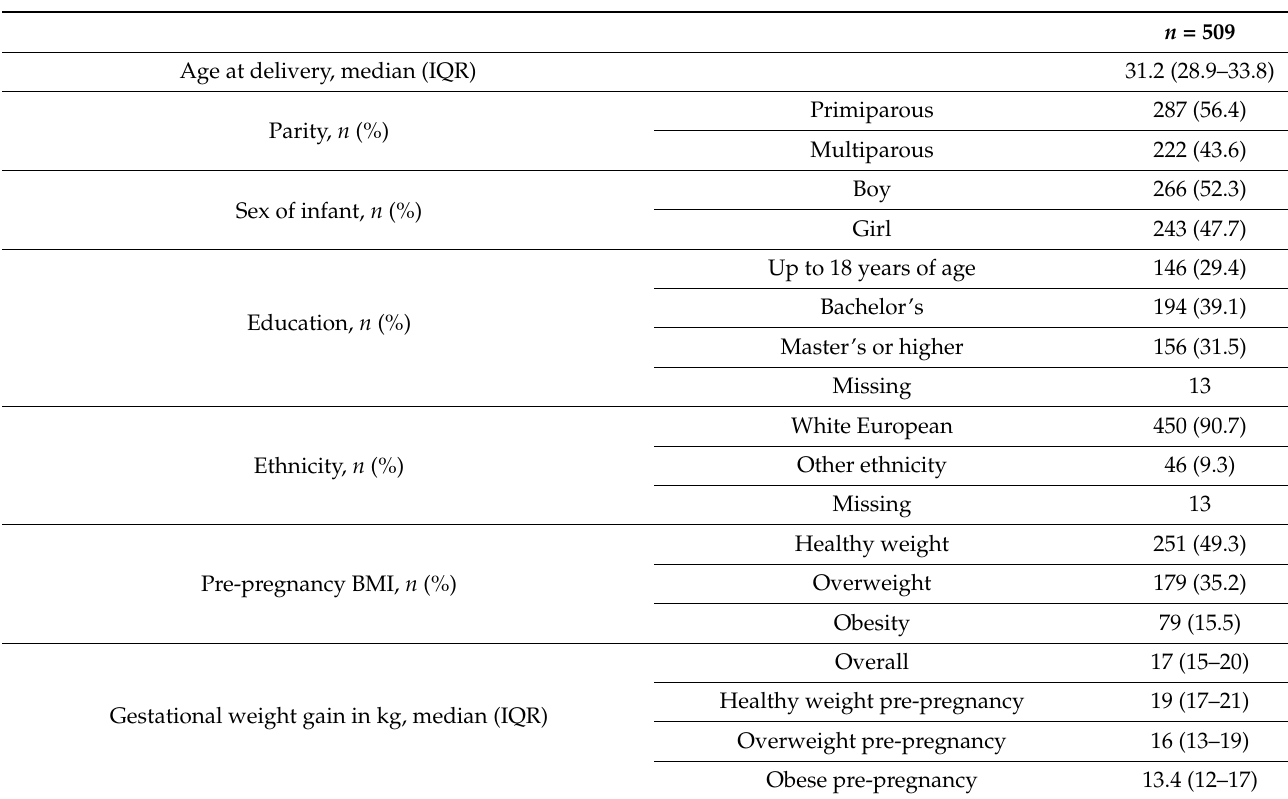
Figure 1. Flowchart of participant follow-ups. Table 1. Participant baseline